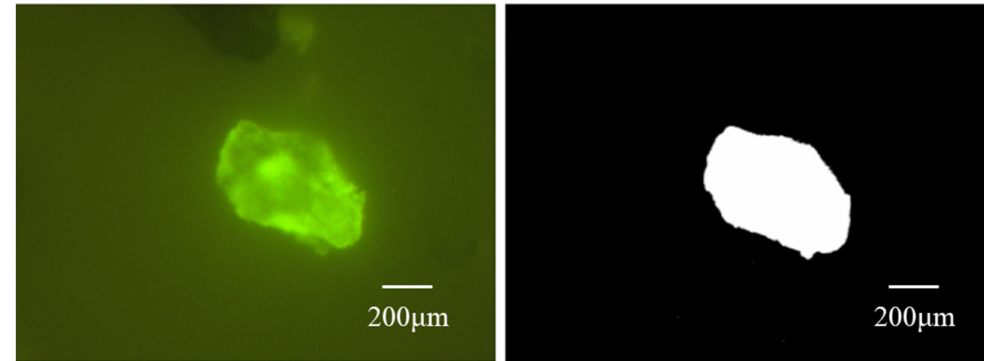
Figure 1. The typical example of a Fluorescence microscope scanning image (left) and the image processed by MATLAB